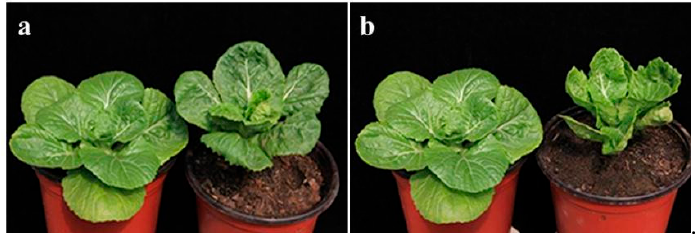
Figure 4. Two leaf shape mutants. ( a , b ) The wild-type ‘FT’ plant (left) and crinkled leaf mutant (right). Five leafy head mutants were detected in the M 1 generation, and the mutation fre- quency was 0.4%. Two vertical leafy head mutants (Figure 5a,b right) and three small leafy head mutants (Figure 5c right) were identified.